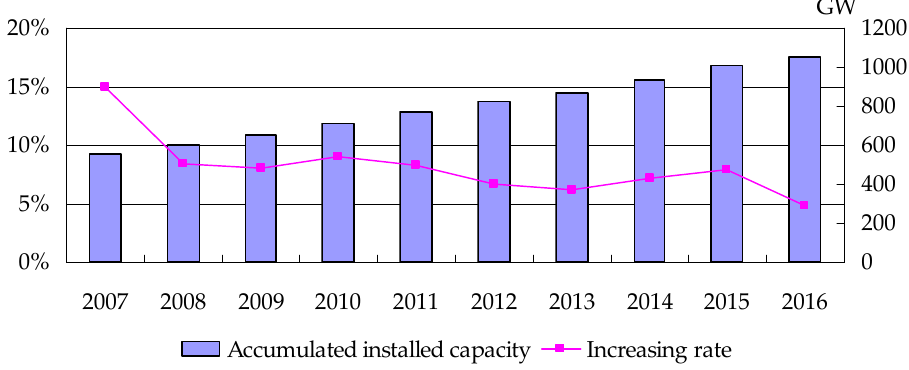
Figure 3. Accumulated installed capacity and its increasing rate of thermal power from 2007 to 2016 in China.